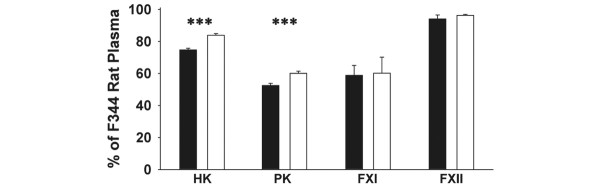
Kallikrein–kinin system (KKS) assays. Plasma KKS protein concentrations in the human leukocyte antigen B27 transgenic rats treated with control monoclonal antibody IgG (filled bars) or monoclonal antibody C11C1 (open bars) at day 16 of the experimental protocol. Values were compared with a pool of normal Fischer 344 rat plasma. Both high-molecular-mass kininogen (HK) and prekallikrein (PK) were significantly decreased in the IgG1-treated group and were closer to normal in the C11C1-treated group. Both experimental groups showed decreased factor XI (FXI) with no significant differences between them. There were no significant changes between any groups in factor XII (FXII). ***P < 0.005.